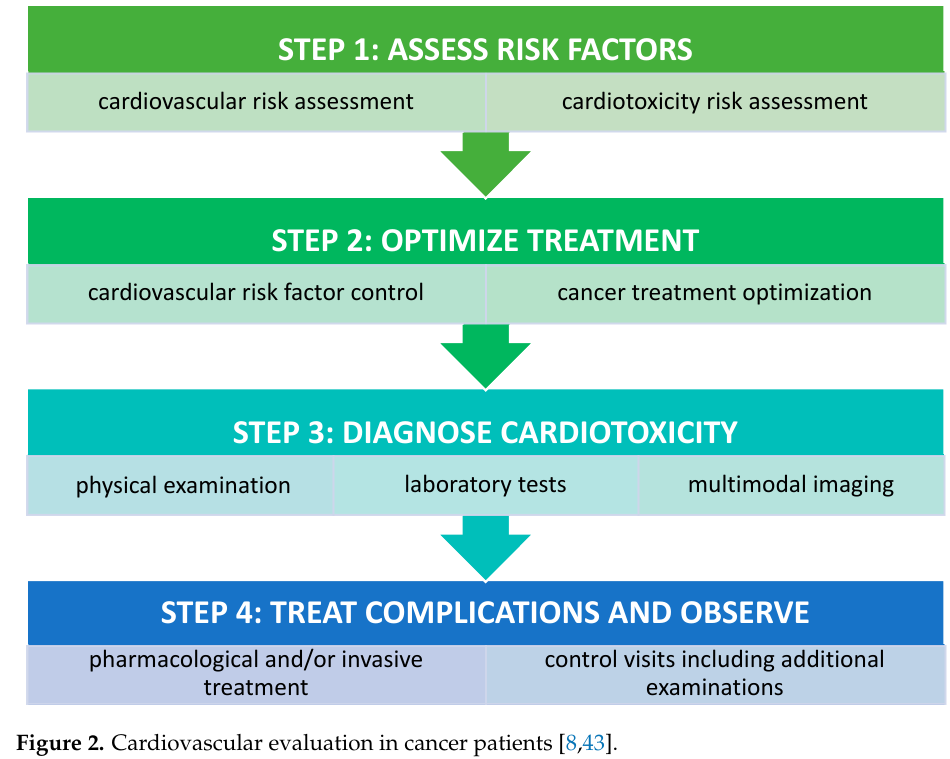
Figure 2. Cardiovascular evaluation in cancer patients [8,43].